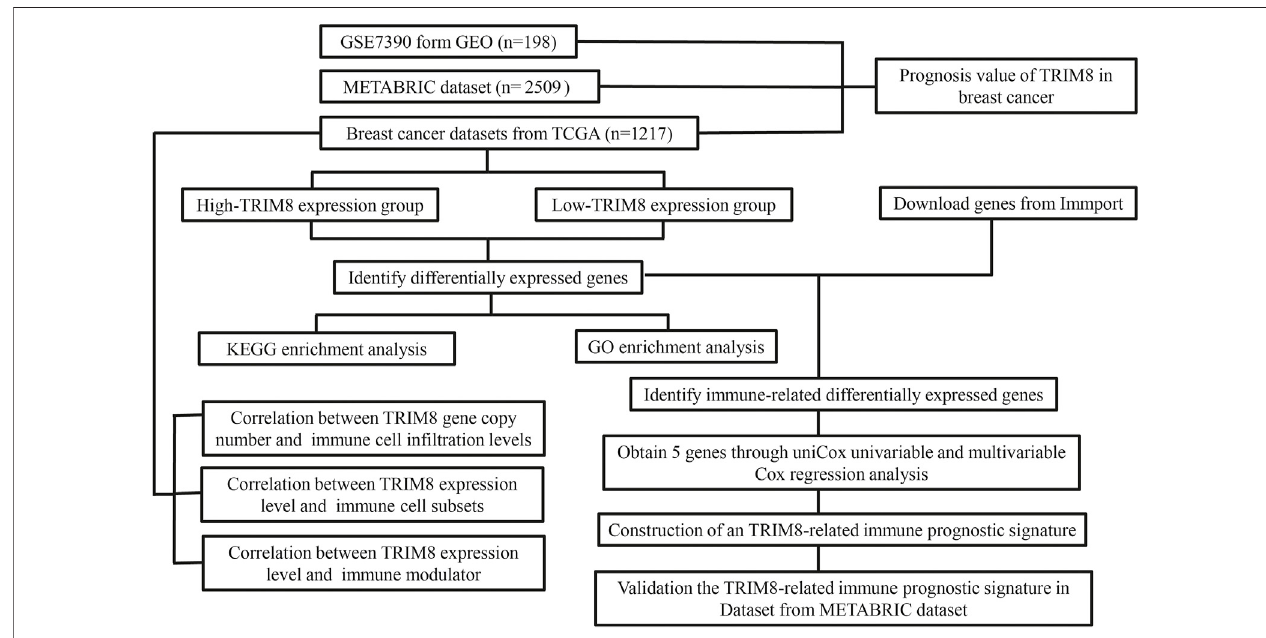
FIGURE 1 | Flowchart of the major steps in this